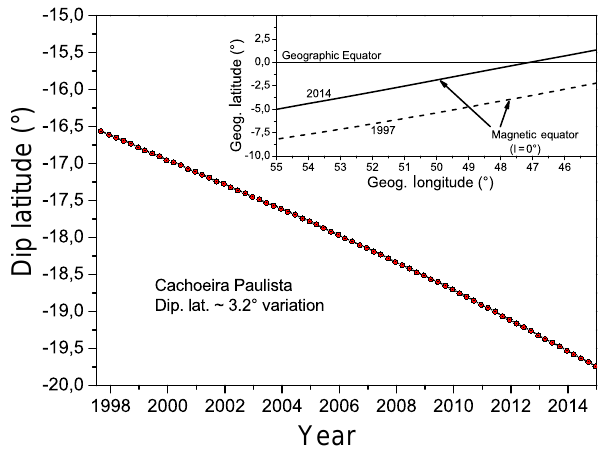
Figure 2. Variations in the dip latitude of Cachoeira Paulista (line with circles) and in the magnetic dip equator (panel in the top cor- ner) during the period from 1997 to